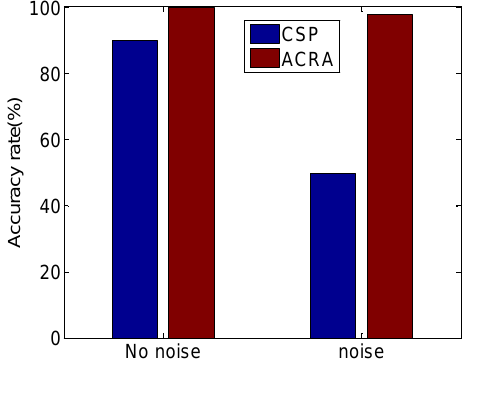
Figure 17. Statistical results of the experimental